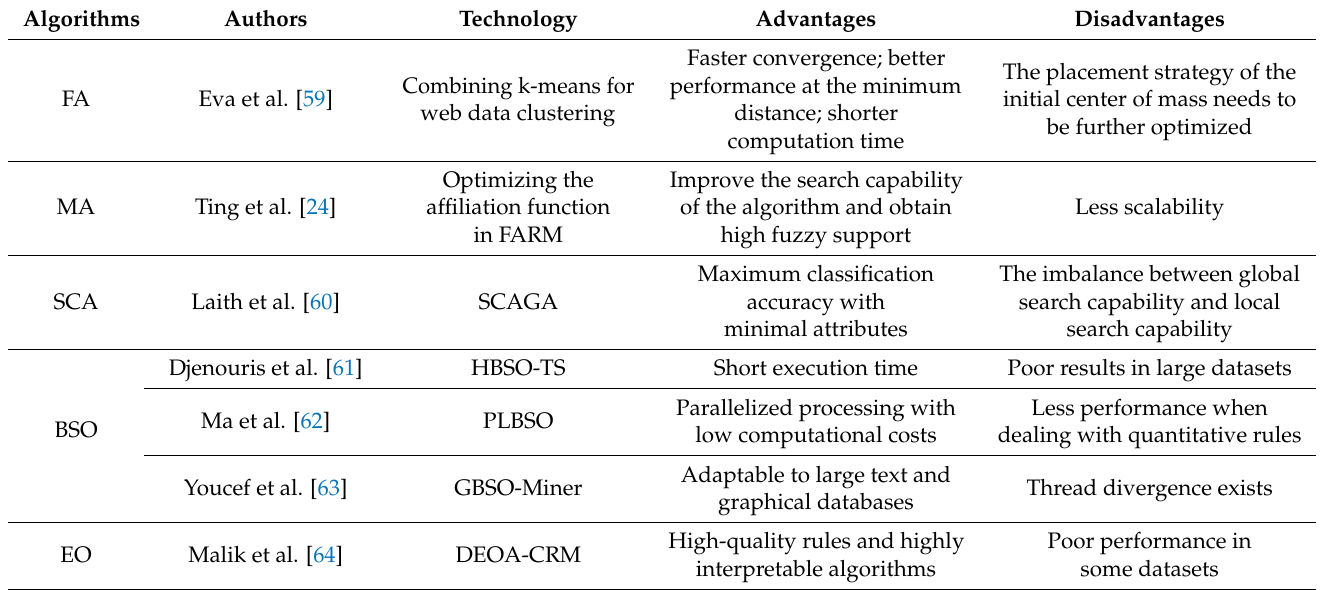
Table 4. ARM, based on other heuristic